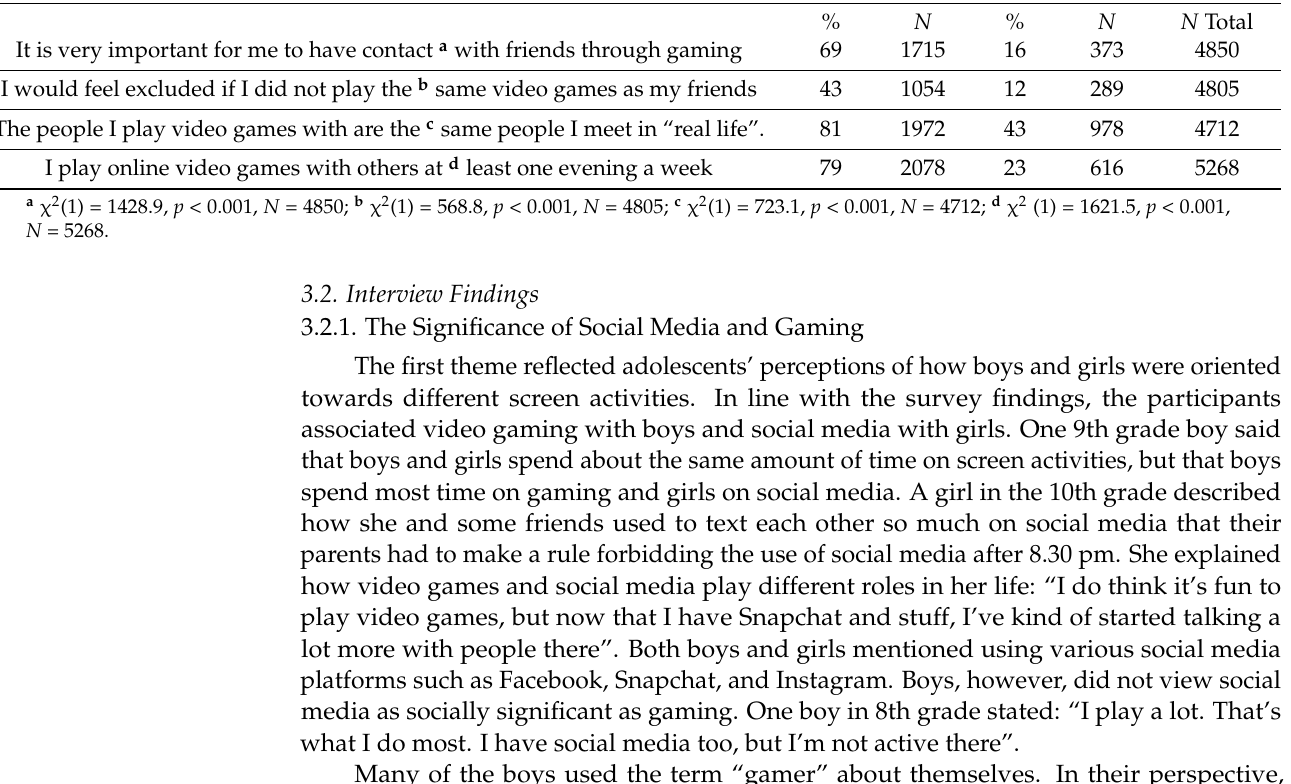
Table 1. Gaming and friendship by gender. Numbers and percentages of those who answered yes. Variable Boys Girls % N % N N Total 69